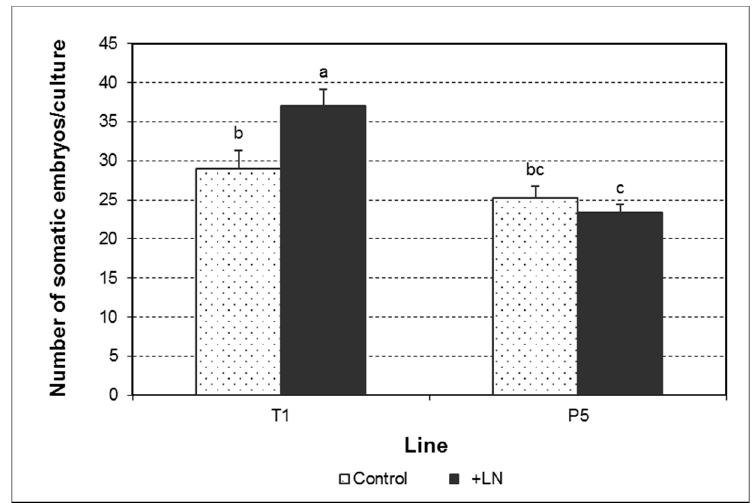
Figure 3. Number of somatic embryos developed per culture during the proliferation phase from control and cryopreserved embryogenic cultures of the lines T1 and P5. Data assessed six weeks after the last subculture. Data represent the mean ± SEM. Different letters indicate significant differences by the LSD test with a significance level of 0.05.